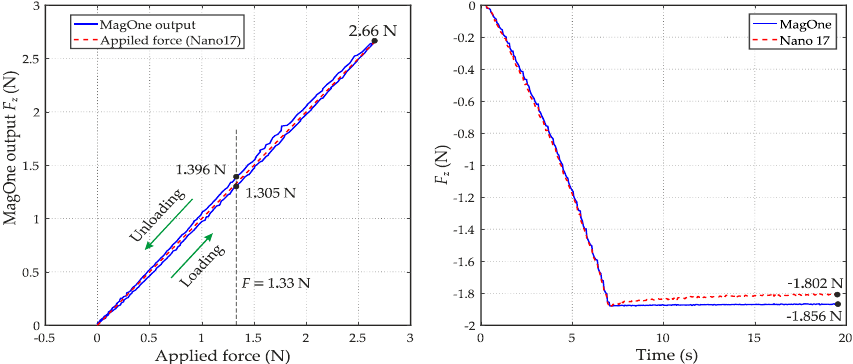
Figure 15. ( a ) Hysteresis error of the MagOne sensor; ( b ) Viscoelastic creep effects in the MagOne elastomer.